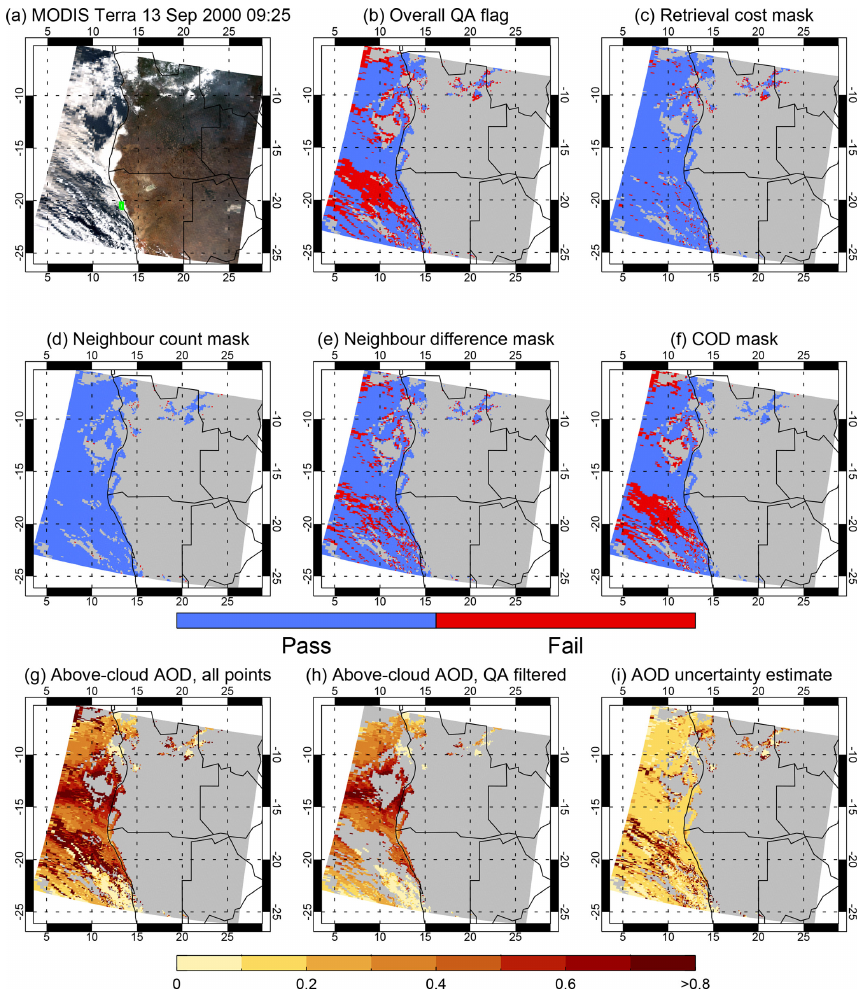
Figure 4. AAC retrieval for a MODIS Terra granule during SAFARI-2000 from 13 September 2000. Panels show (a) a true-colour image; (b) the overall QA flag; ( c – f ) results of individual QA tests, as described in the text; (g, h) the retrieved AOD before and after applying QA tests; and (i) the estimated uncertainty on retrieved AOD at 550nm. The green box in (a) shows the region used for comparison with airborne data by Sayer et al. (2016). Pixels without valid retrievals are shaded in